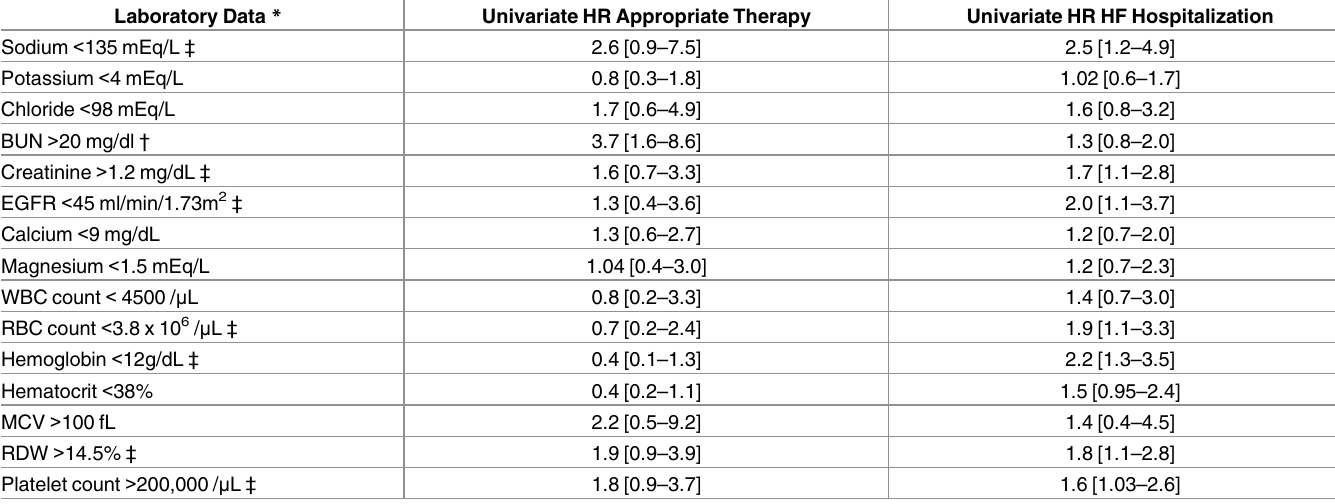
for score categories 1, 2 and 3, respectively (p < 0.001) ( Fig 2B ). All-cause mortality was strongly associated with HF score category with greater risk for death with higher HF scores ( Fig 3A ). The relationship between death and appropriate therapy score Table 4. Unadjusted hazard ratios [HR] for appropriate therapy and HF hospitalization–laboratory data. Laboratory Data *